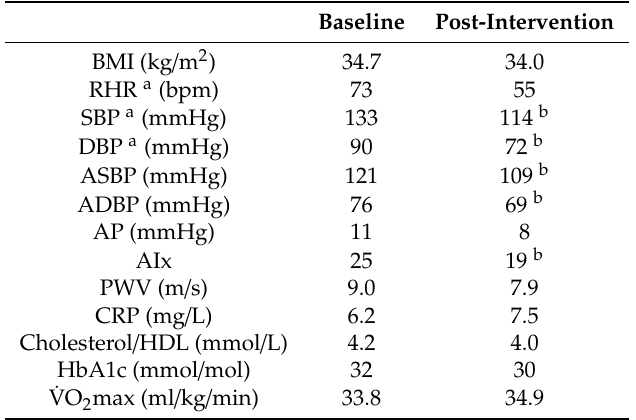
Table 4. Case characteristics and selected outcomes in a young man with more than 10 years as a shift worker performing 2–3 recorded weekly PA interventions during follow-up. Baseline